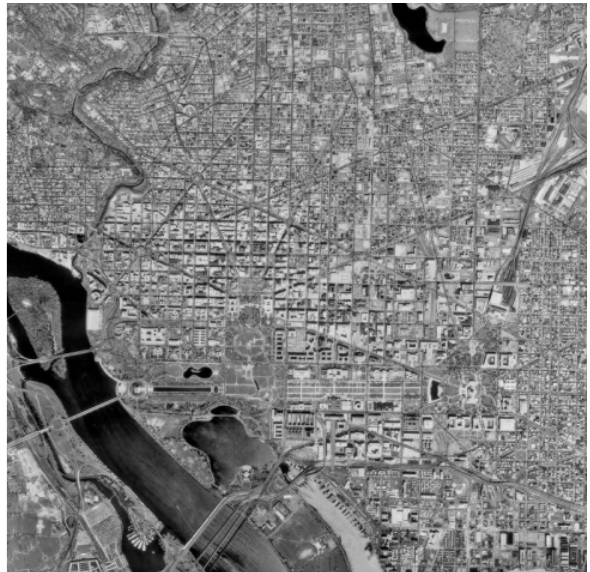
Figure 1. Example Landsat-3 RBV Image of Elko, Nevada